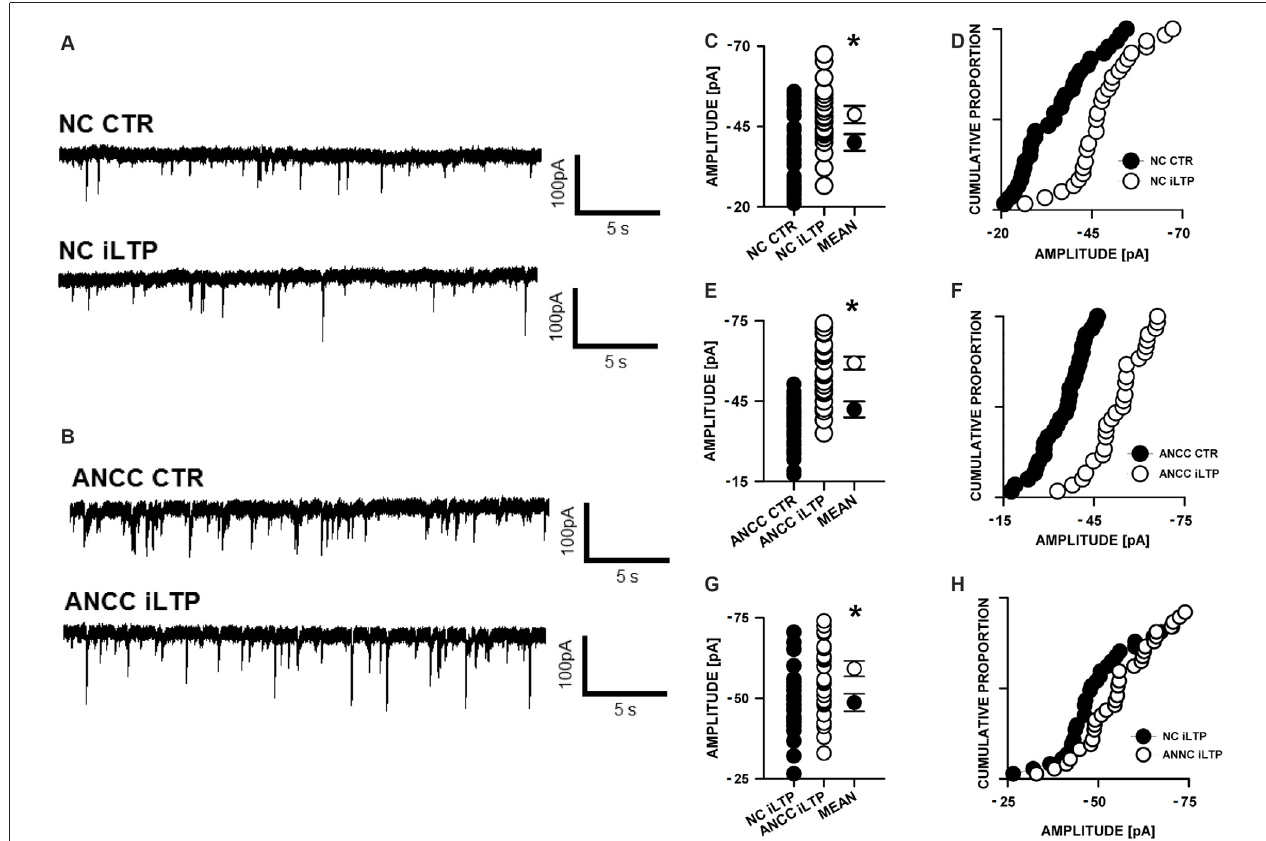
FIGURE 2 | Supplementation of neuronal cultures (NC) with astrocytes strongly upregulates inhibitory long-term potentiation (iLTP). (A) Typical traces obtained in NC. (B) Typical traces from astrocyte-neuronal co-culture (ANCC), upper one present control measurement, lower one after iLTP induction. (C,D) Comparisons of mIPSC amplitude values obtained in NC with or without iLTP induction. (E,F) Comparisons of mIPSC amplitude values obtained in ANCC with or without iLTP induction. (G,H) Comparisons of mIPSC amplitude values obtained in NC and ANCC with iLTP induction. Statistical significant results in scatter plots ( p < 0.05) are represented with star